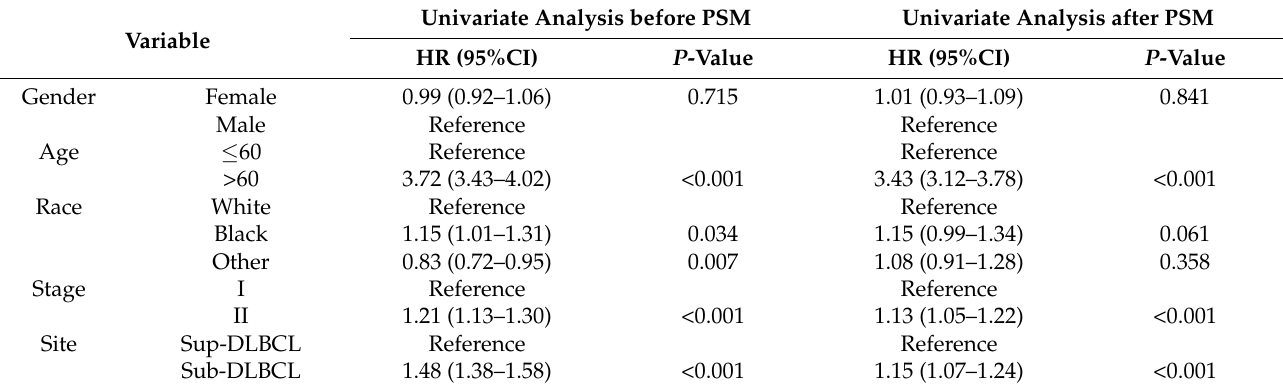
Table 4. The univariate analysis before and after PSM.